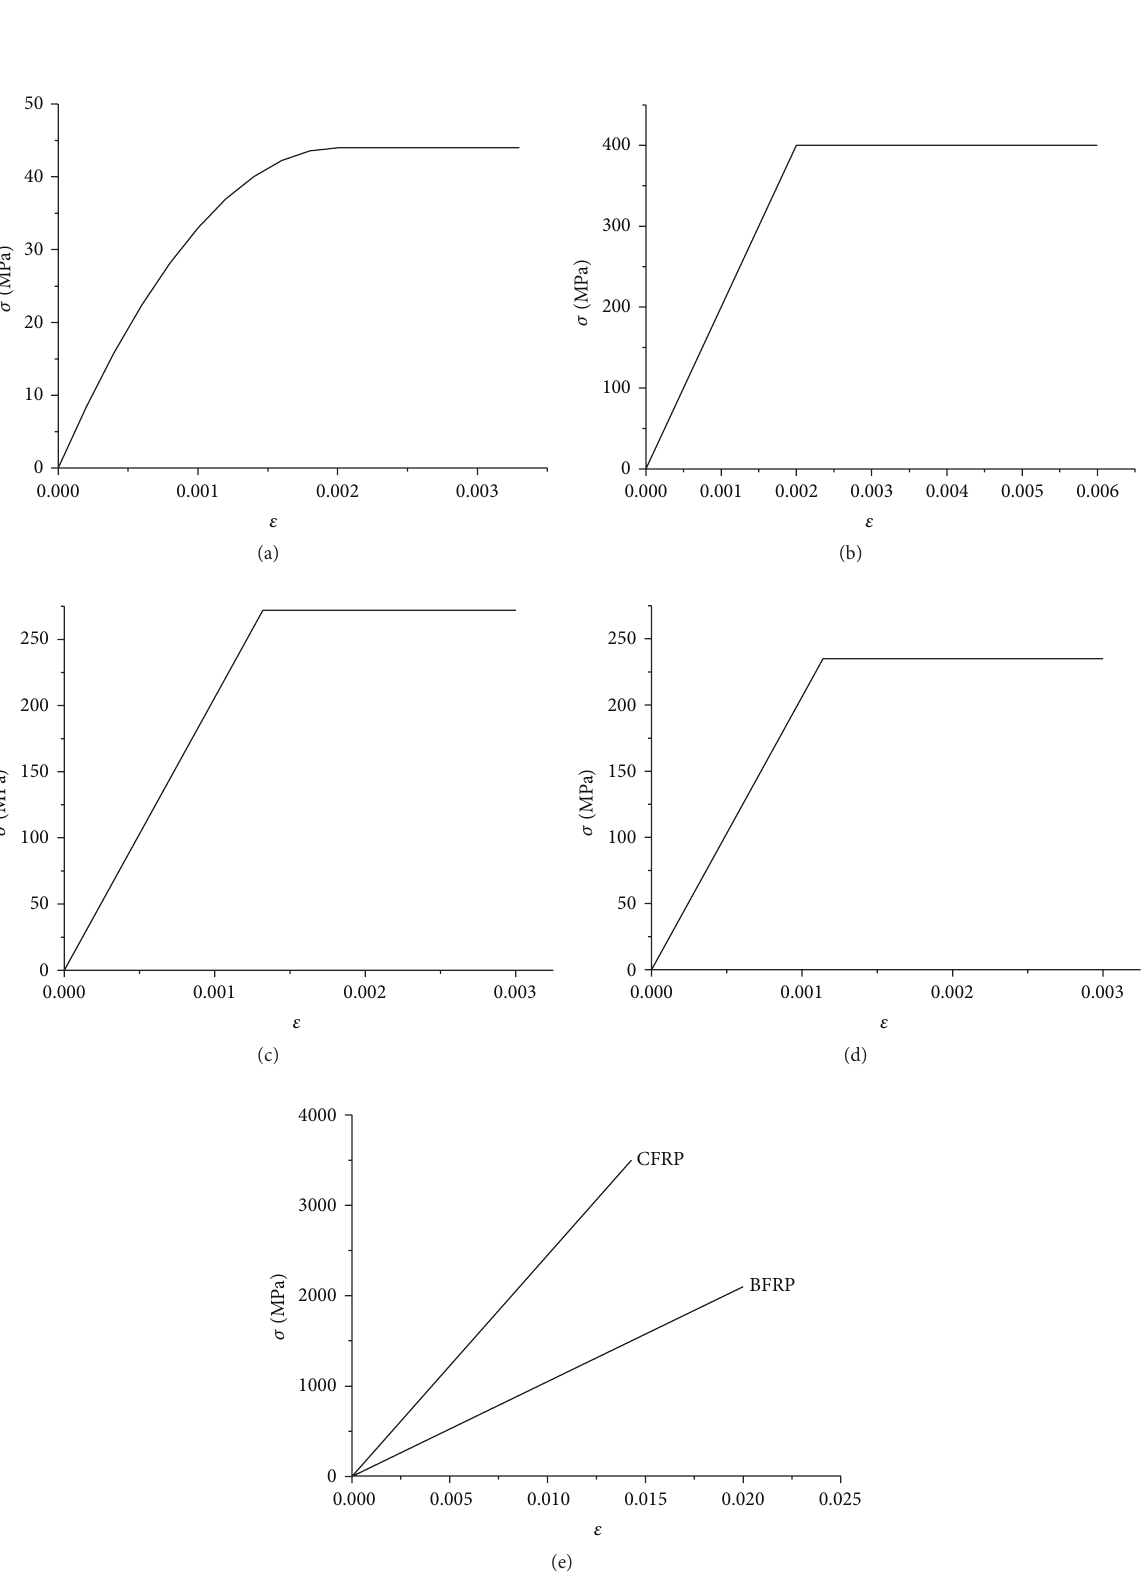
Figure 11: Stress-strain curve of materials: (a) concrete; (b) longitudinal reinforcement; (c) stirrup reinforcement; (d) steel tube; (e)